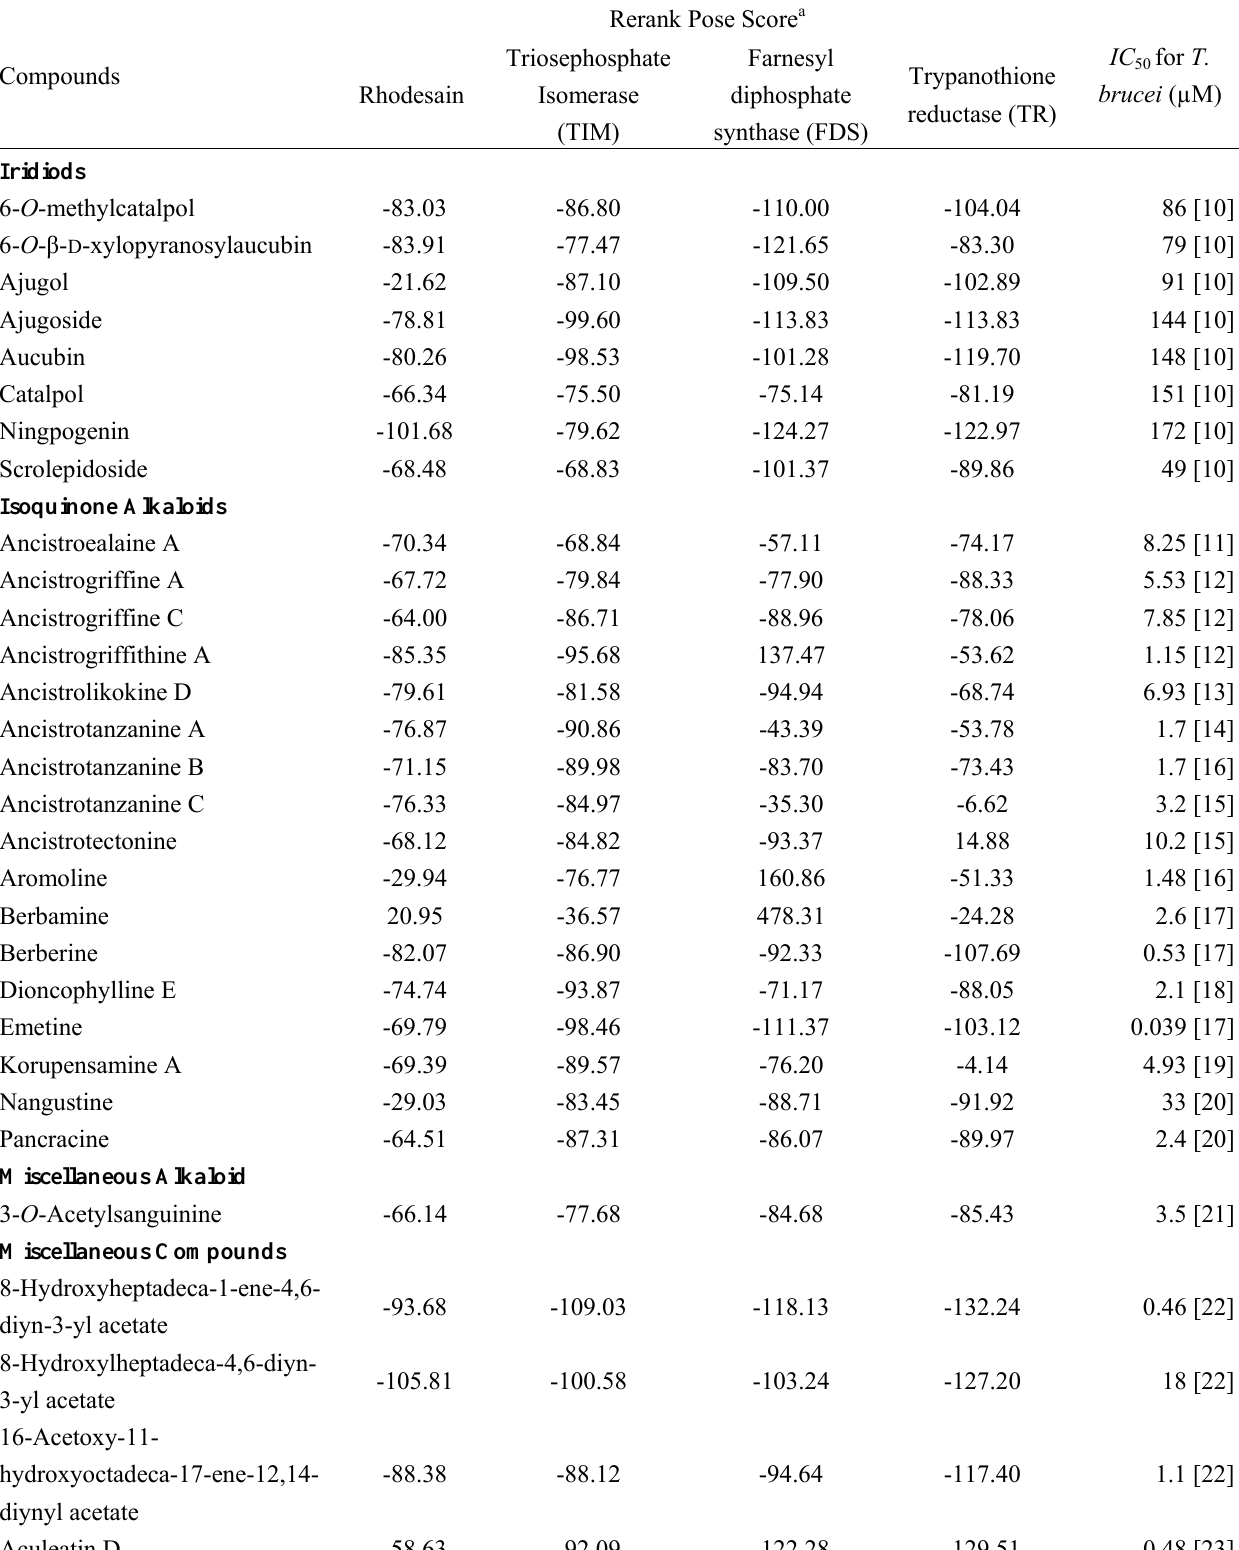
Table 1. Molecular docking pose scores of antitrypanosomal agents and the reported IC for T.